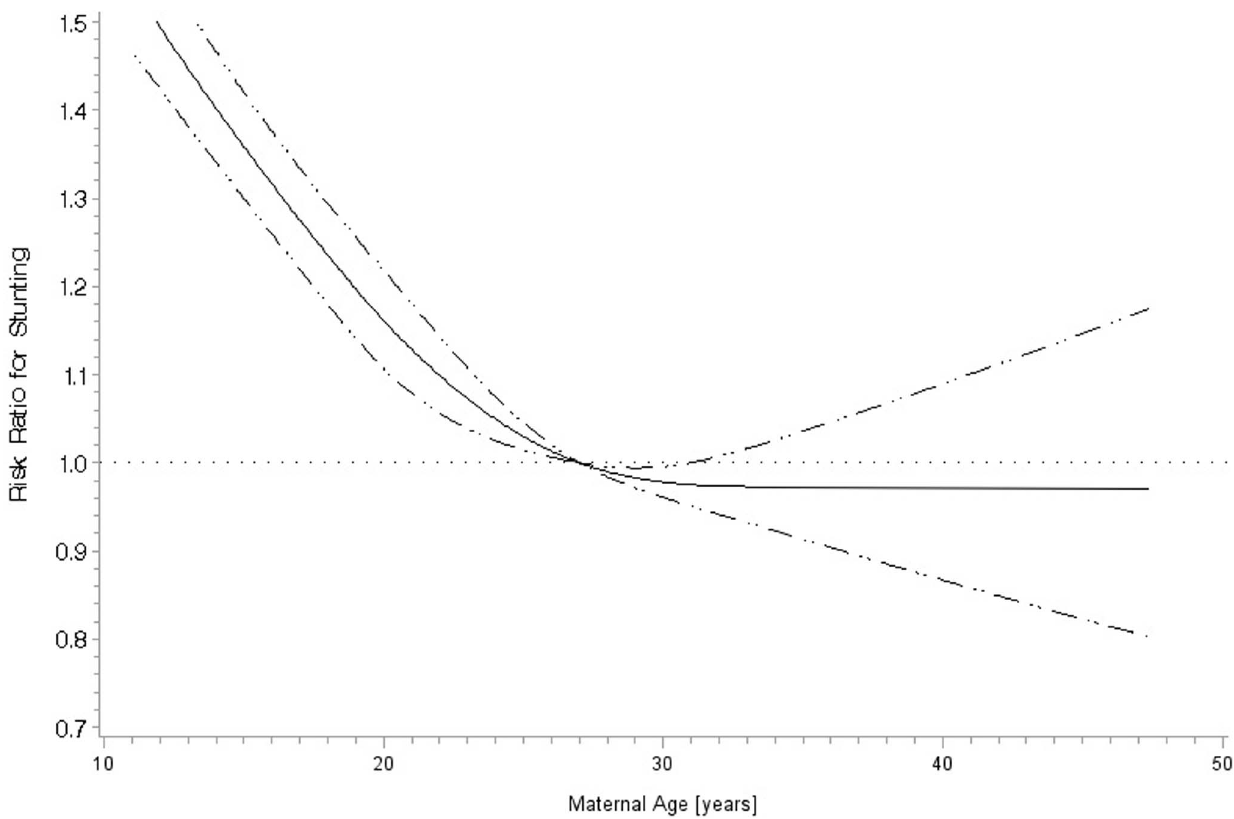
Figure 1. Non-linear adjusted a relationship of maternal age with stunting for firstborn children b . a Adjusted for same factors as Table 1 Caption. b 27 years is the reference group (p-value for non-linear relationship: , 0.001).